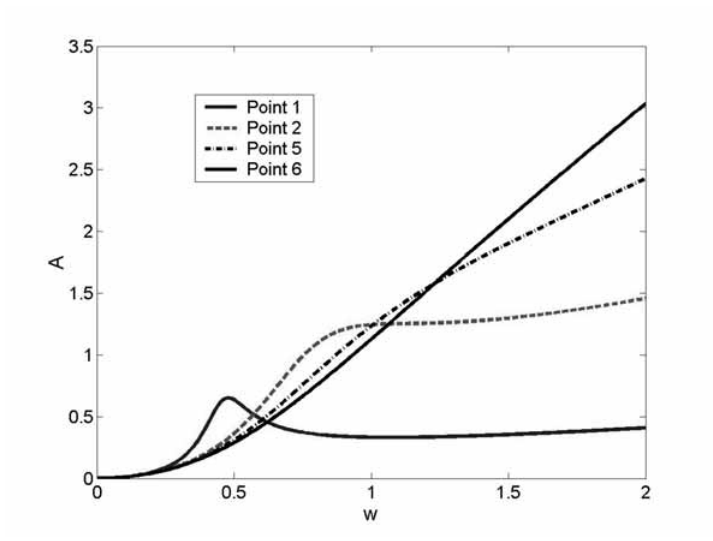
Fig. 30. Optimized absolute acceleration frequency